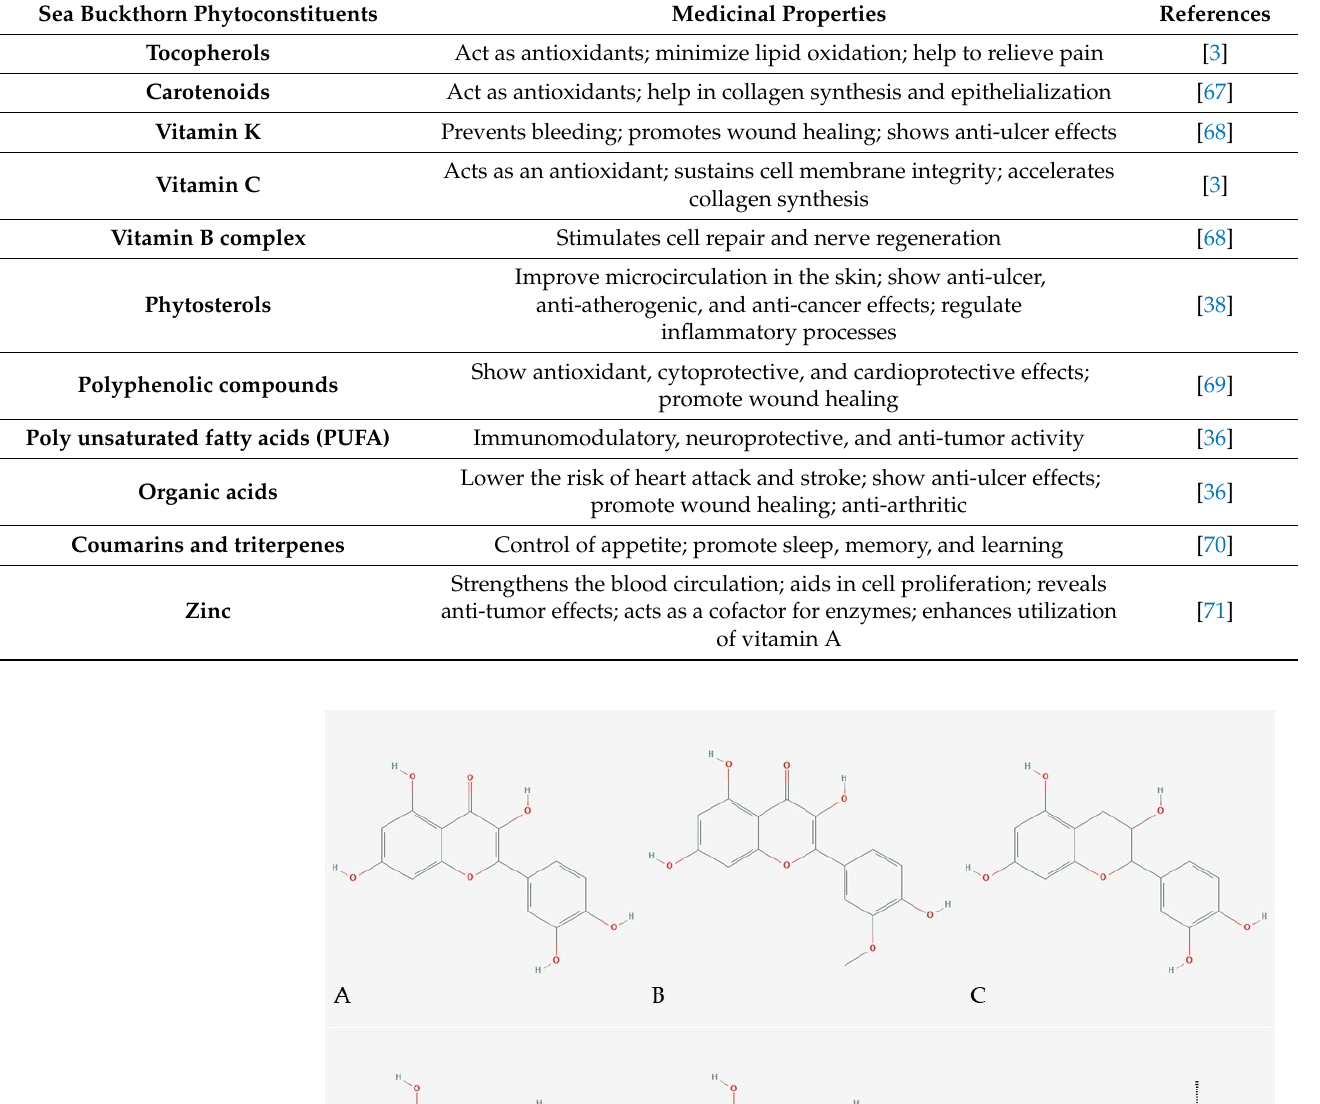
Table 2. Major phytochemicals in sea buckthorn and their medicinal properties.